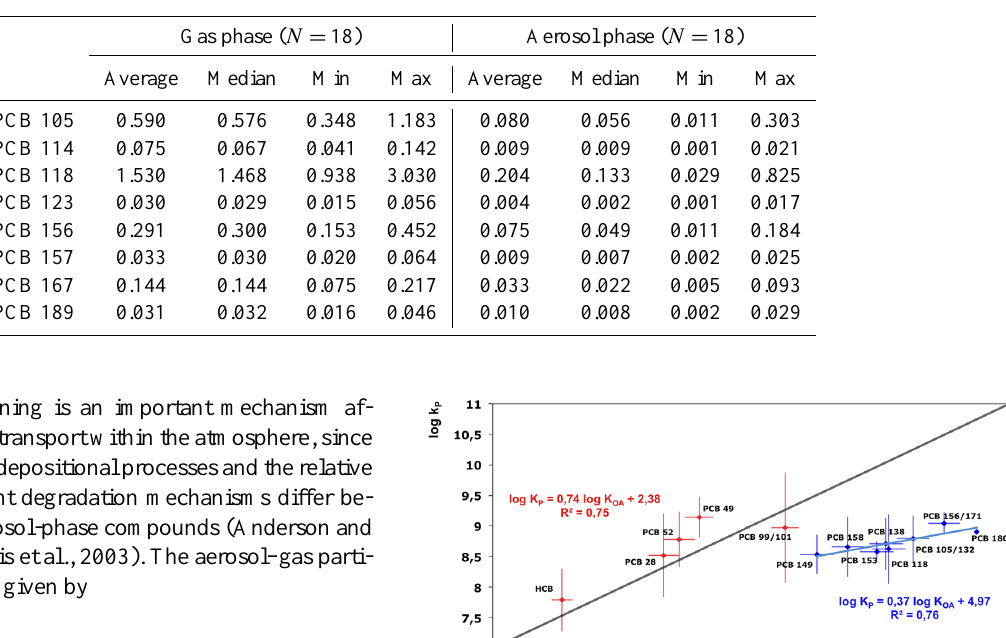
Table 3. Mono-ortho substituted PCB congeners in gas and aerosol phase inpgm − 3 .